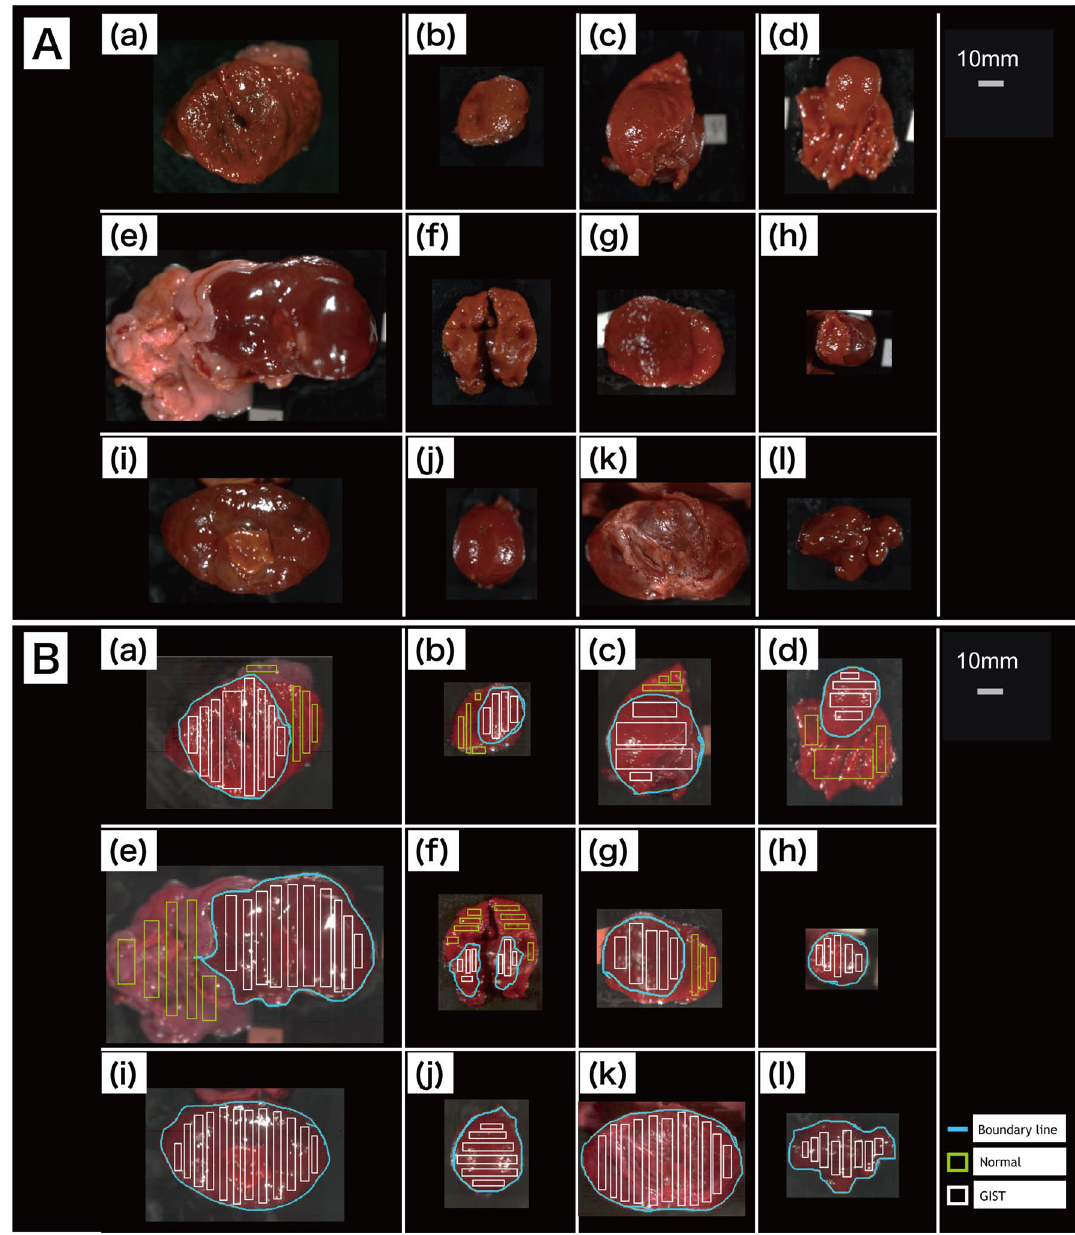
Figure 2. NIR image and preparation of training data. ( A ) (a–l) Pseudo-colored pictures of specimens captured by Compovision (NIR camera) (R: 1065 nm, G: 1280 nm, B: 1981 nm). ( B ) (a–l) Boundary line between GIST and normal region drawn by pathologist (blue), and bounding boxes for training data (green: normal tissue, white: GIST). NIR near-infrared, GIST gastrointestinal